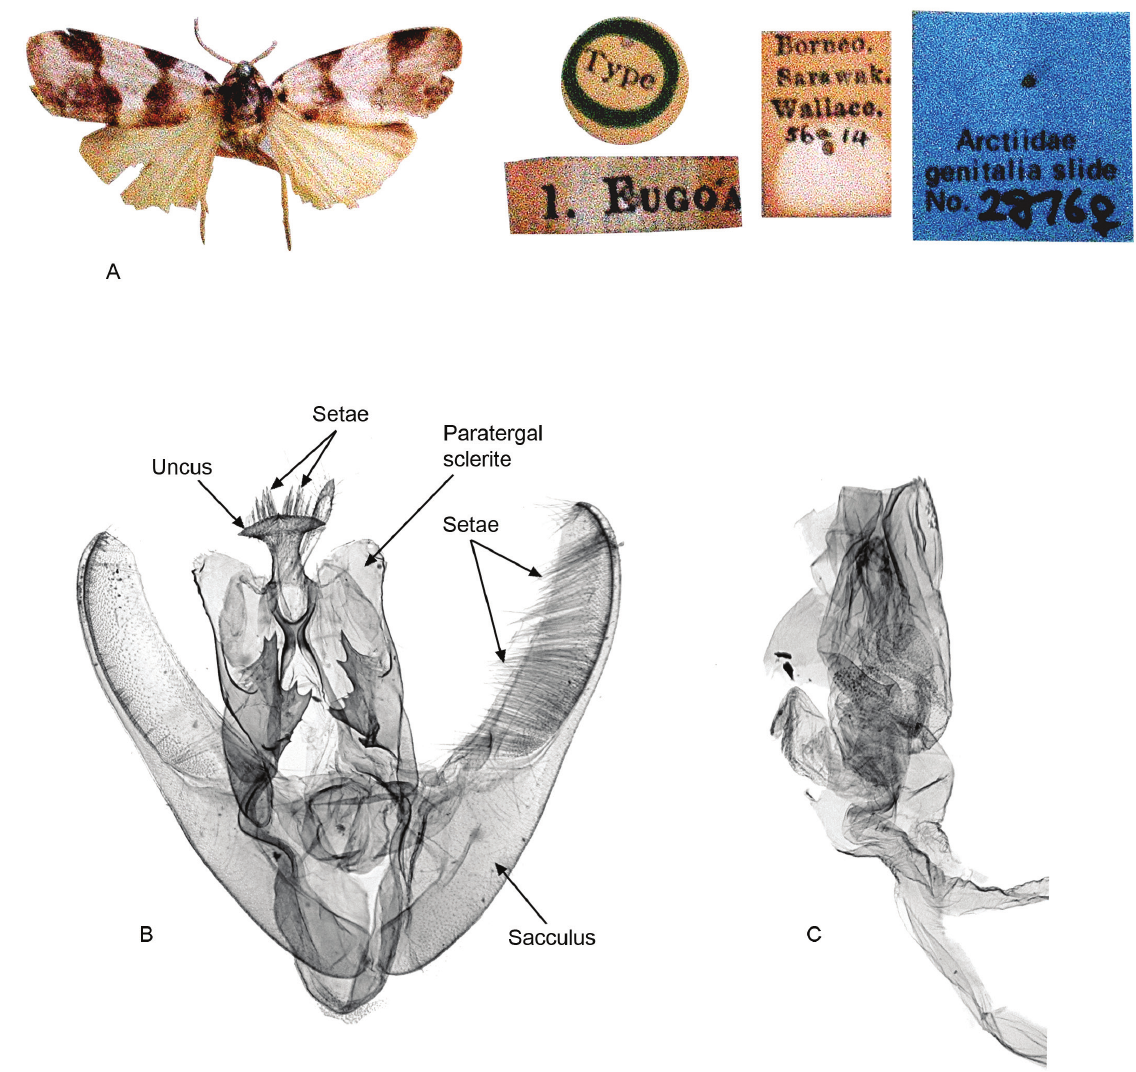
Fig. 6. Eugoa aequalis (Walker, 1857) . A . Holotype ♀, Borneo, in BMNH. B . ♂ genitalia, g.sl. BM ARCT 5057, Borneo. C . Aedeagus, g.sl. BM ARCT 5057,